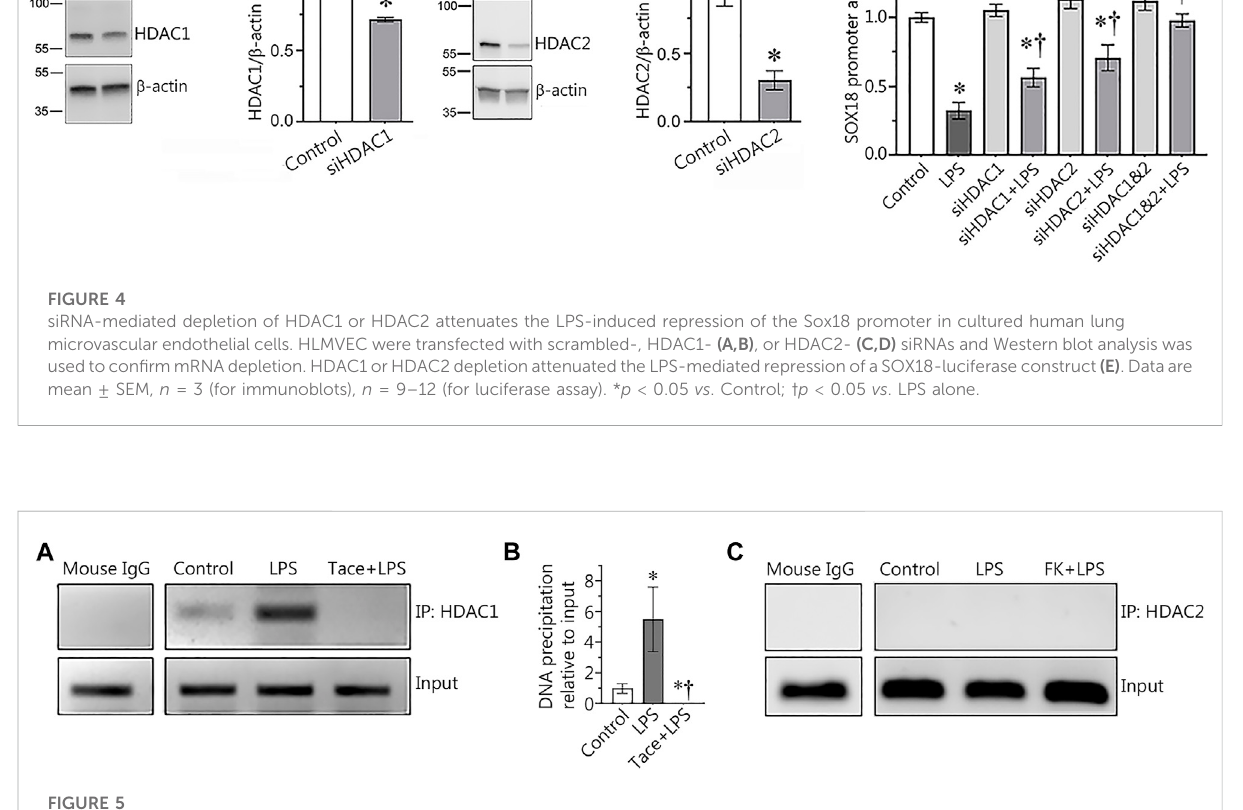
FIGURE 5 Chromatinimmunoprecipitation(ChIP)analysisofHDAC1andHDAC2inLPStreatedhumanlungmicrovascularendothelialcells.LPSincreased the association of HDAC1 with the NF- κ B-binding site 1 ( − 1082 to − 1073 bp) within the Sox18 promoter sequence, and this was prevented by tacedinaline pre-treatment (A,B) . The association of HDAC2 with the NF- κ B-binding site 1 was not detected in HLMVEC in the presence or absence of LPS (C) . Data are mean ± SEM, n = 3 – 5. * p < 0.05 vs . Control; † p < 0.05 vs . LPS